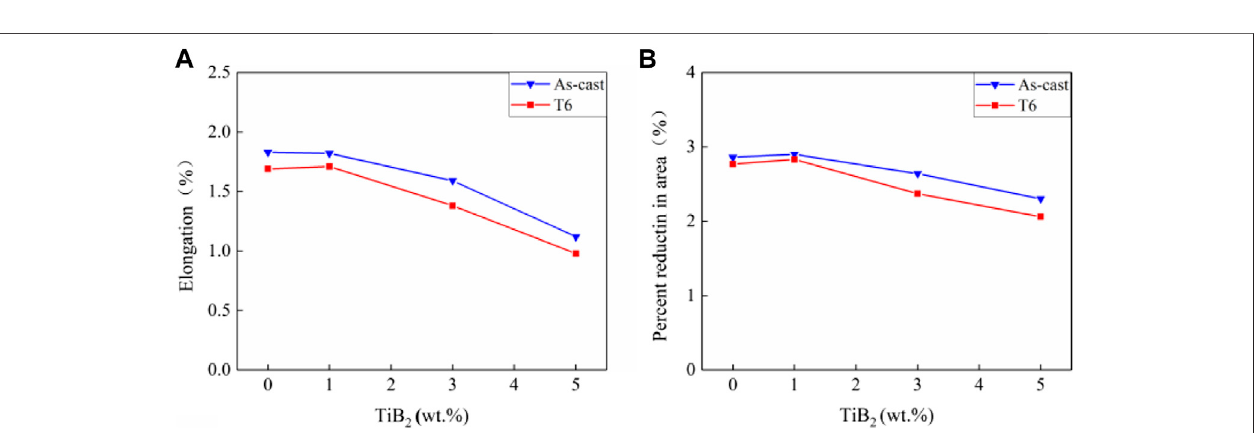
FIGURE 10 | Effect of TiB 2 content on: (A) Percent elongation, and (B) Percent reduction in area of TiB 2 /A356 composites.